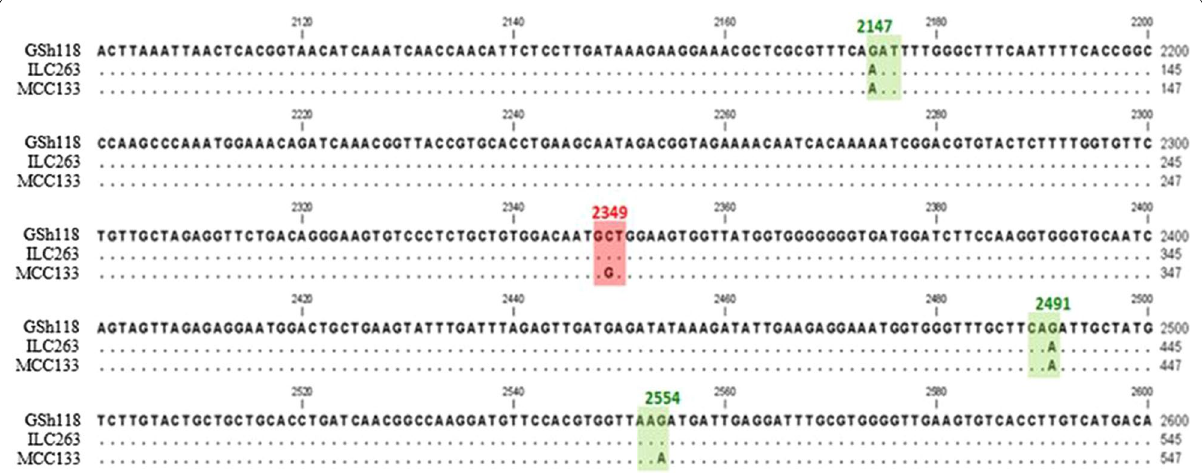
Fig. 4 Multiple sequence alignment of the DNA region amplified by PSh118-F/R primer pair in two chickpea lines; MCC133 (resistant) and ILC263 (sensitive) in comparison with the reference sequence presented in gene bank (Gene ID: 105851082). Numbers are the position of the nucleotides relative to the start codon. Dark backgrounds show the position of SNPs in the codon. The 2349 position is corresponded to SNP18. The positions of 2147, 2491 and 2554 are related to SNP18-2147, SNP18-2491 and SNP18-2554, respectively. Similar sequences are shown as dot